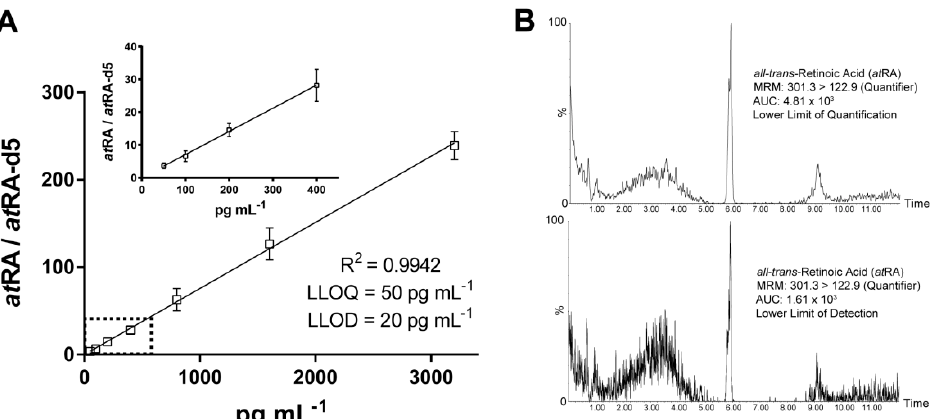
Figure 1. Parameters of linearity and limitations. ( A ) Calibration range (50–3200 pg · mL − 1 ); lower limit of quantification (LLOQ) (signal-to-noise ratio, 6.4/1); lower limit of detection (LLOD; signal-to-noise ratio, 3.2/1) and coefficient of determination (R2). ( B ) Total ion chromatogram of all-trans retinoic acid ( at RA) for LLOQ (top) and LLOD